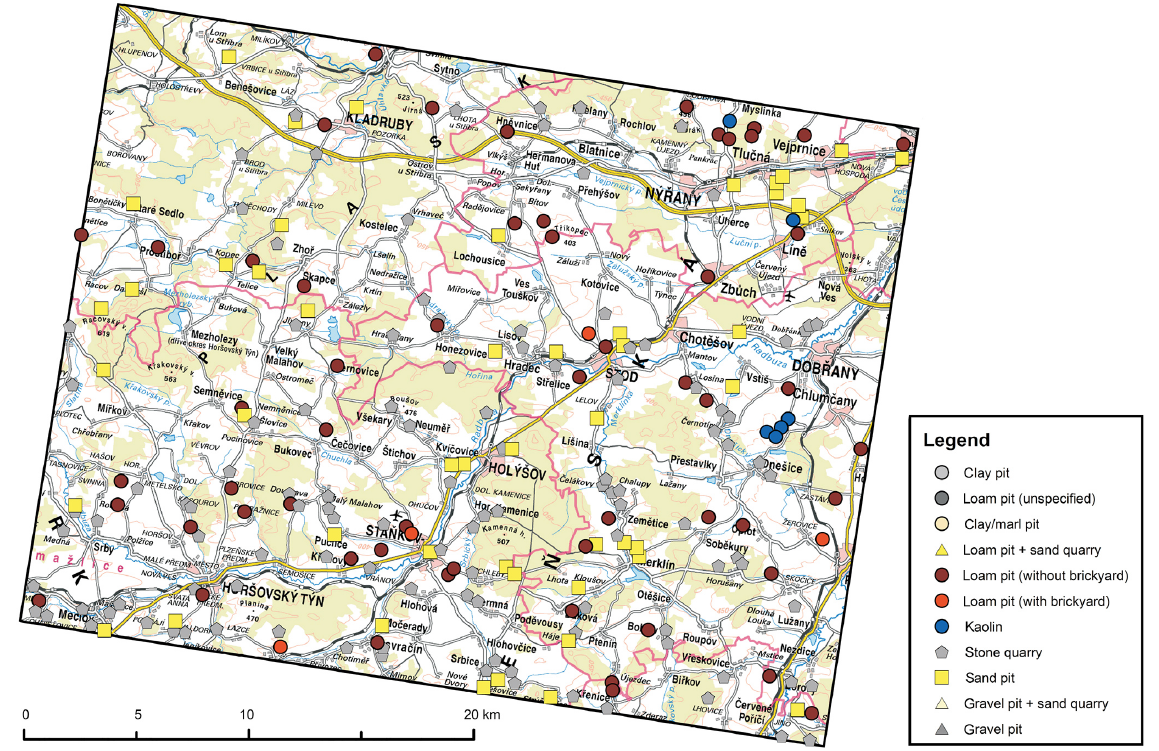
Figure 1. Example of the mining site distribution in the map sheet of the special map 1 : 75000 Horšovský Týn 4150.